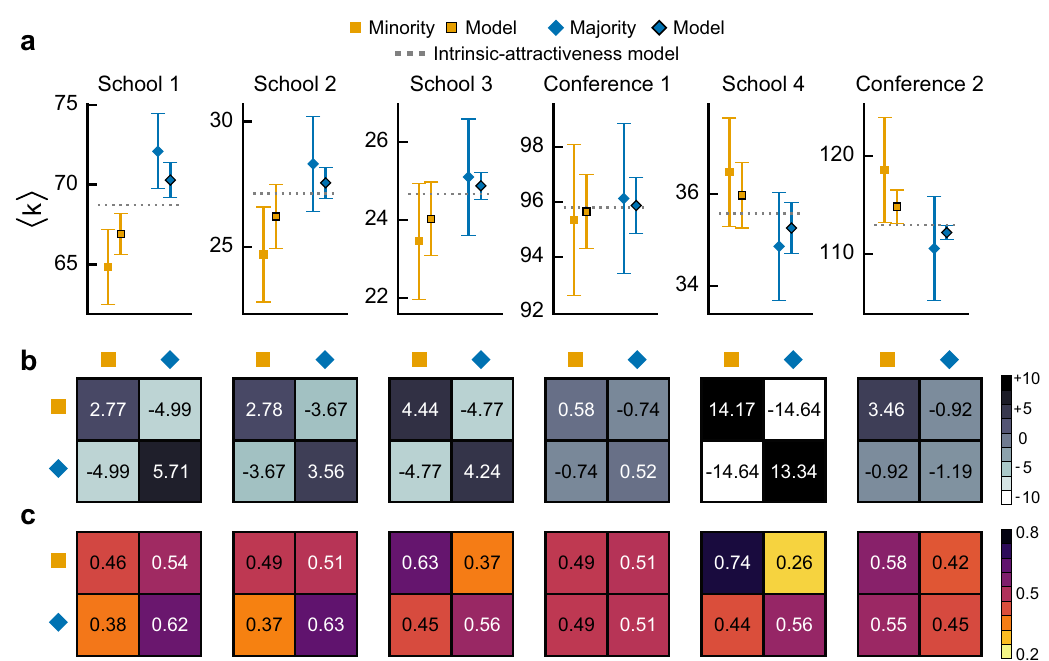
Fig. 1 Face-to-face interaction: degree inequality and group mixing. a The average degree of the minority and majority groups in six empirical data sets of face-to-face interaction. Systematically, some groups have a higher average degree than others. An intrinsic-attractiveness model (dashed lines) is unable to explain these differences. The error bars are the standard error of the mean. b The intra- and intergroup interaction in these social gatherings. The z score values correspond to the comparison against the null model: the higher the value, the more often groups interact. In most cases, individuals are more likely to interact with individuals from the same group. c The estimated mixing matrix H from the data sets. The matrix describes the likelihood of groups connecting among themselves. With the estimated mixing matrix, we simulate the attractiveness – mixing model and ( a ) show that the model (symbols with black outline) reproduces the degree inequality observed in the